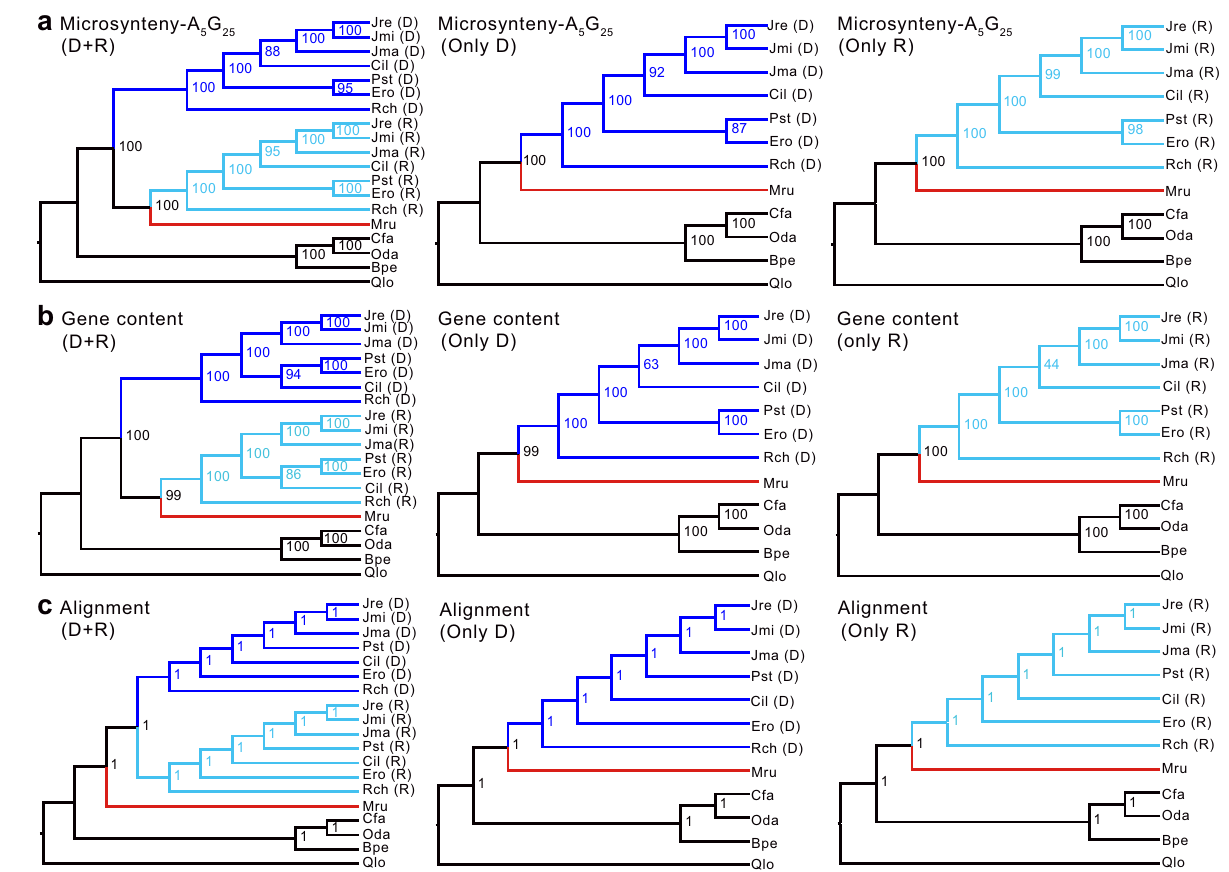
Fig. 5 | Phylogenetic trees of Juglandaceae obtained from whole-genome microsynteny [Syn-MRL], gene content, and sequence alignments. The sub- genomes assigned by homoeologous chromosomes (dominant and recessive subgenomes of the seven Juglandaceae species and the fi ve outgroups; dominant subgenome (D); recessive subgenome (R)). The Juglandaceae species are Carya illinoinensis (Cil), Engelhardia roxburghiana (Ero), Juglans mandshurica (Jma), Juglansmicrocarpa (Jmi), Juglans regia (Jre), Platycaryastrobilacea (Pst), Rhoiptelea chiliantha (Rch) and the outgroups are Betula pendula (Bpe), Carpinus fangiana (Cfa), Myrica rubra (Mru), Ostryopsis davidiana (Oda), Quercus lobata (Qlo). The